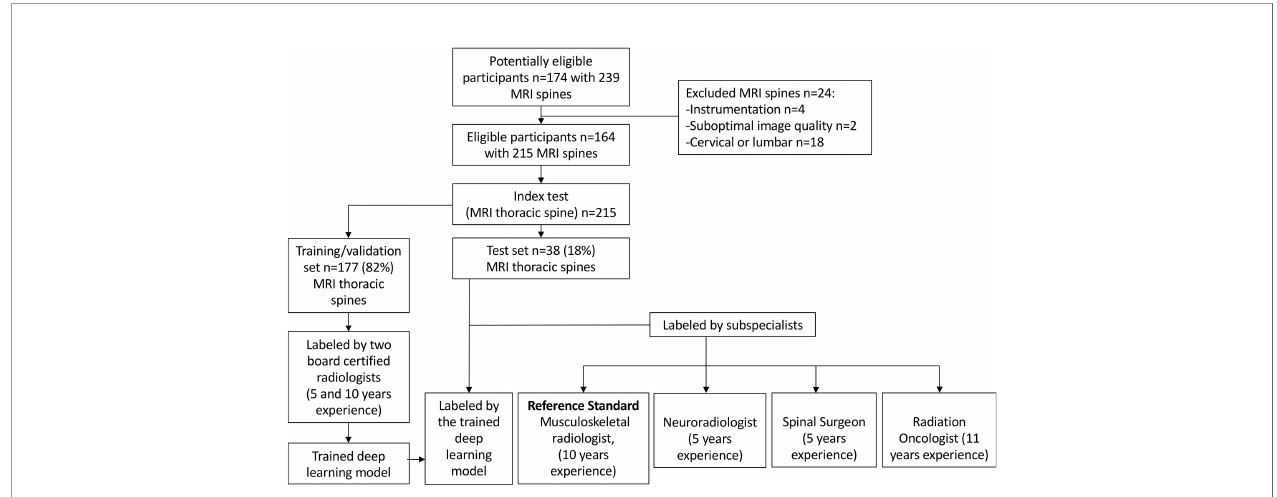
MESCC, malignant epidural spinal cord compression. *Values are mean ± SD (range) for numerical variables and n (%) for categorical variables. # Two or more sites of thoracic epidural